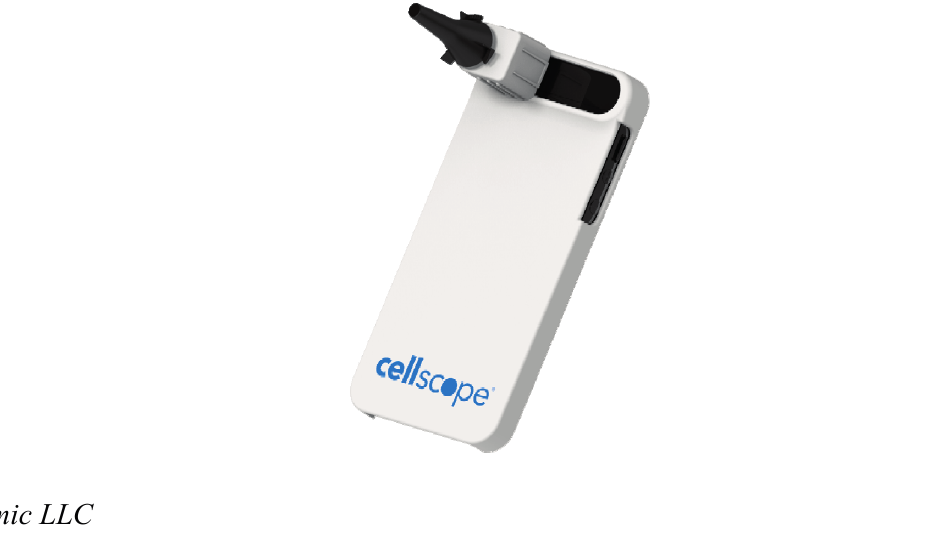
Figure 5. CellScope Oto by CellScope. Image provided by Cori Allen, CellScope,